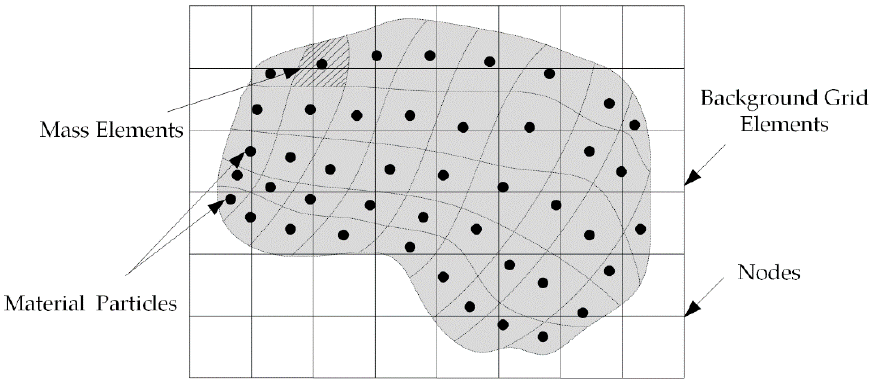
Figure 1. The discrete schematic diagram of the SMPM.